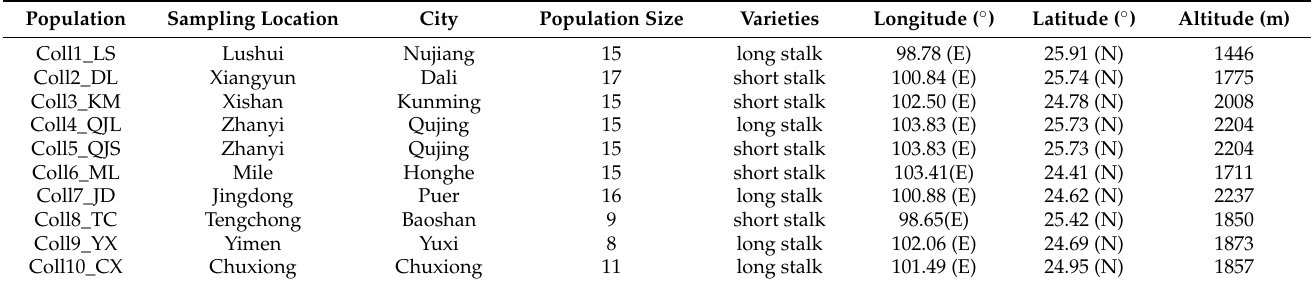
Figure 1. Sampling locations of 10 populations of P. polyphylla var. yunnanensis in the present study. The varieties with different stem heights represent the long-stalked variety and the short-stalked variety, respectively. The population size is also denoted. Table 1. Sampling locations and number of samples analyzed in the present